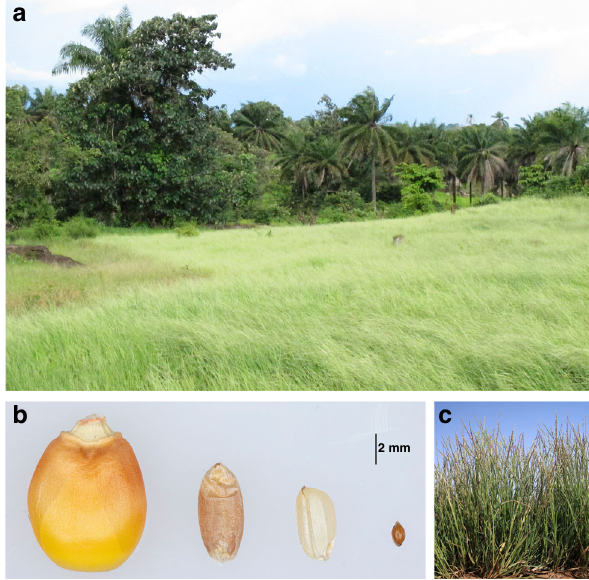
Fig. 1 Phenotype of fonio ( Digitaria exilis ). a Field of cultivated fonio in Guinea. b Grains of maize, wheat, rice, and fonio (from left to right). c Plants of the fonio accession